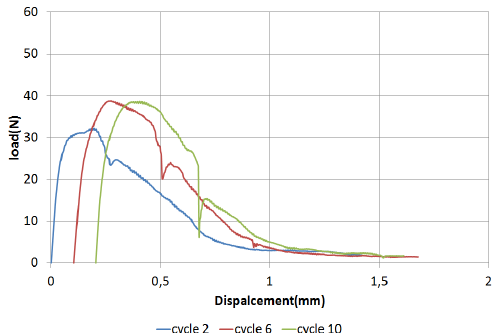
Figure 16: Load vs displacements plot of the extraction test carried out without gel lubricant.